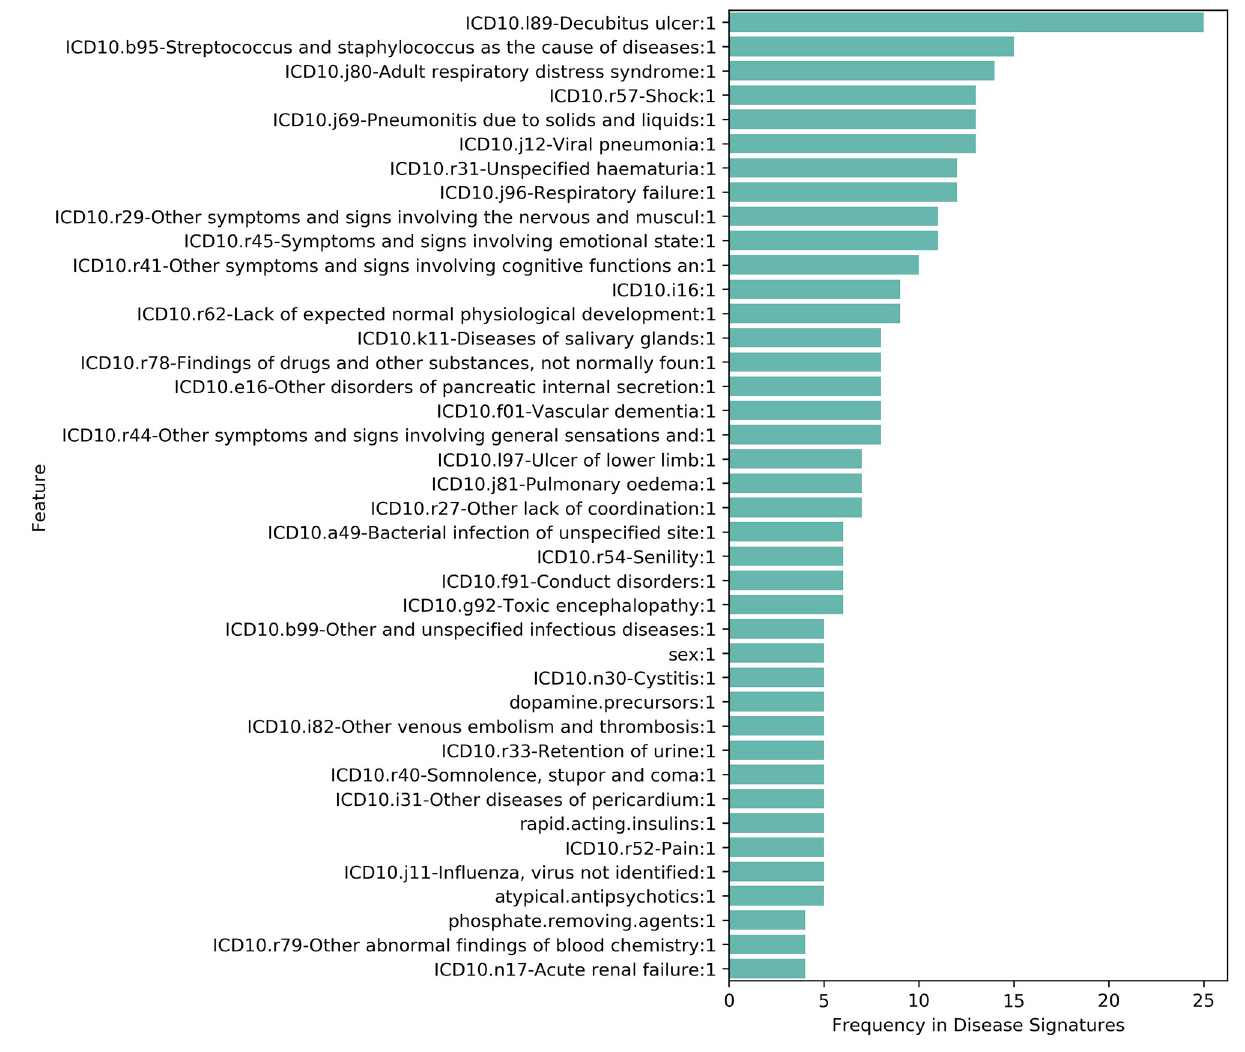
10 patients. The identification of calcium and lipid